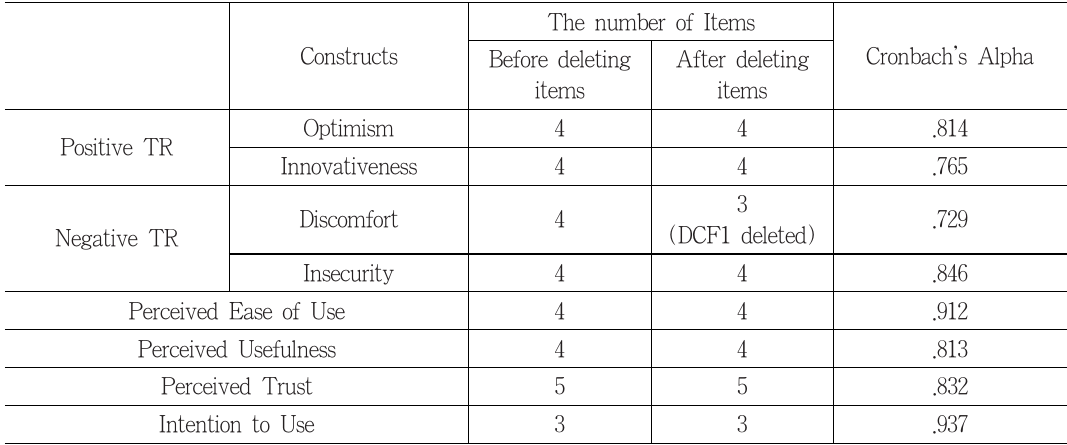
<Table 1> Result of reliability test (Cronbach’s